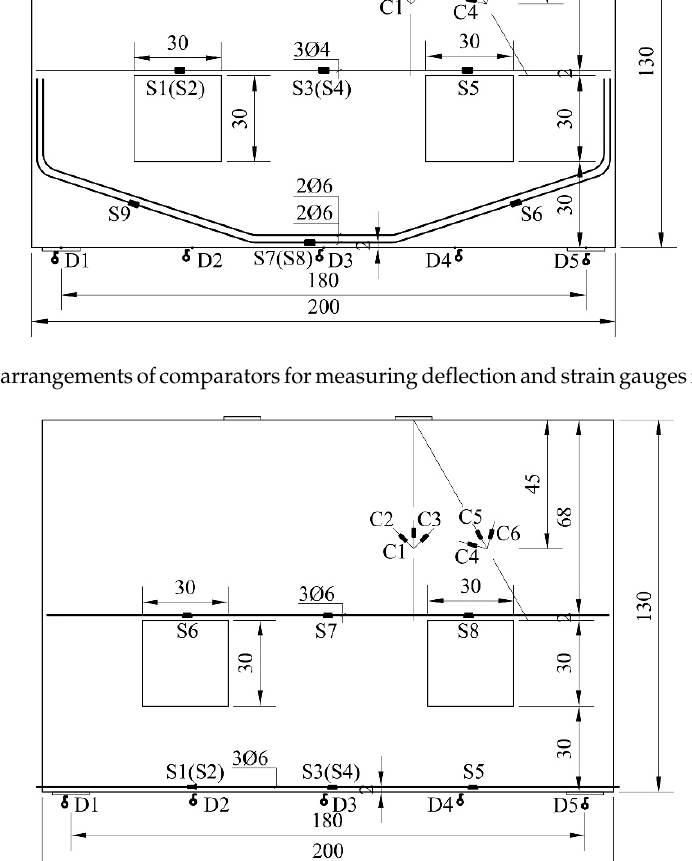
Figure 12. The arrangements of comparators for measuring deflection and strain gauges for specimen Figure12. W2.